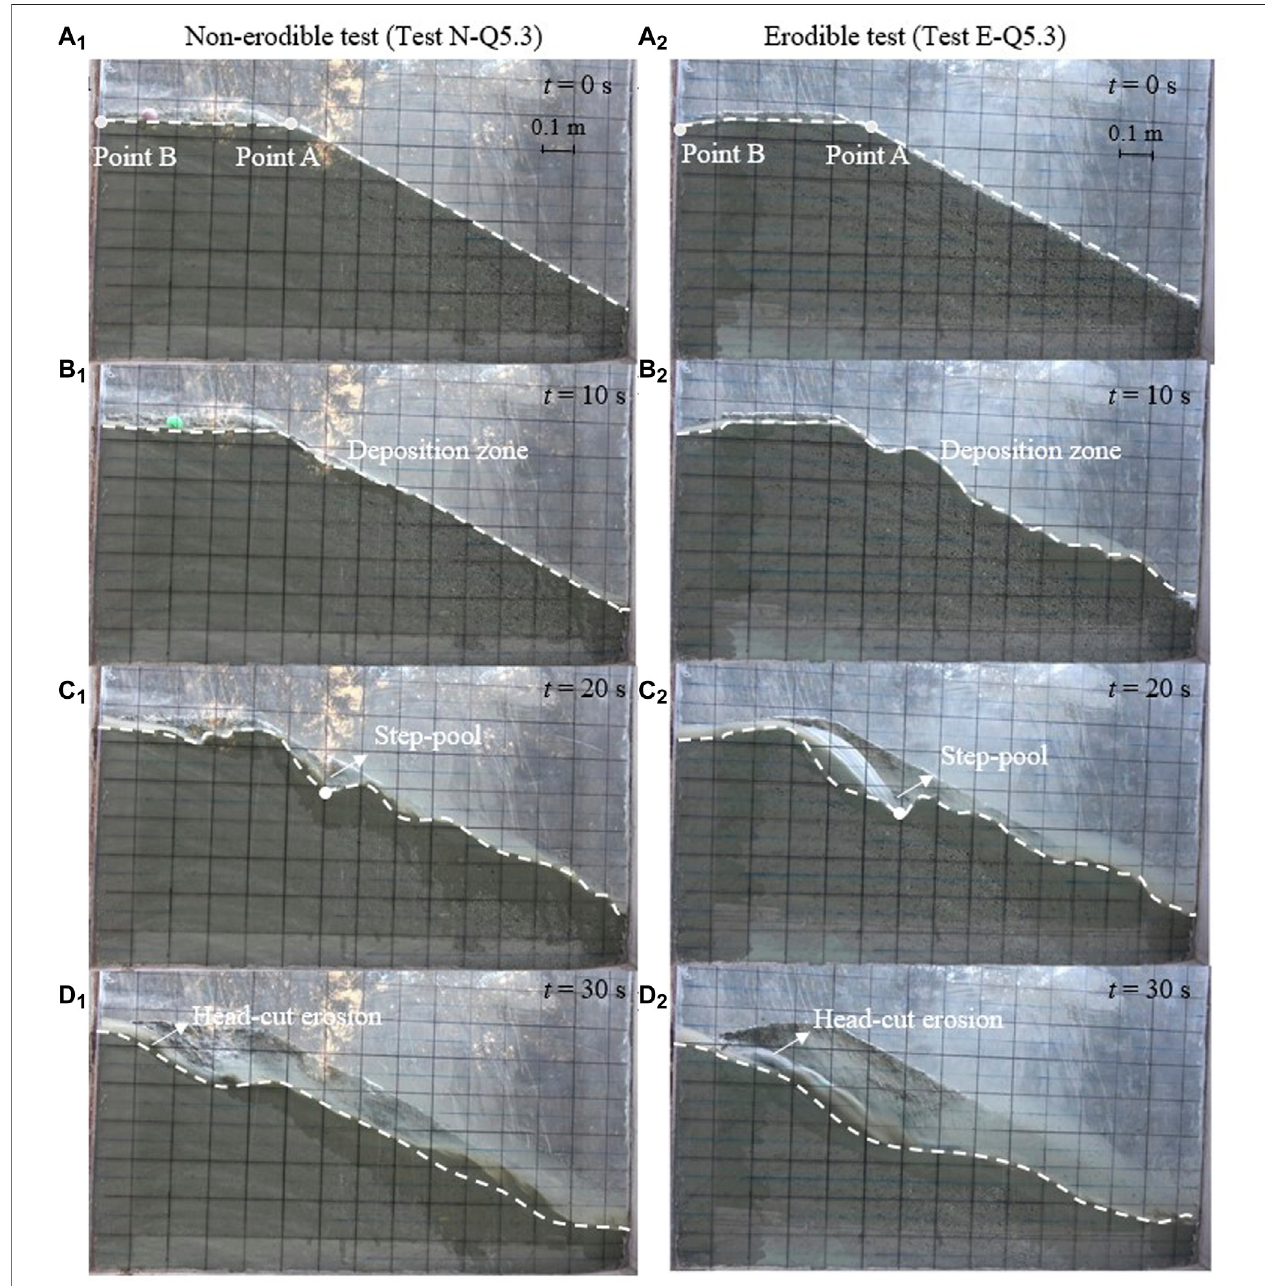
FIGURE 5 | Longitudinal snapshots of the dam-breaching process (Test Nos. N-Q5.3 left side and E-Q5.3 right side). The grid size on the window is 0.1 m × 0.1 m.